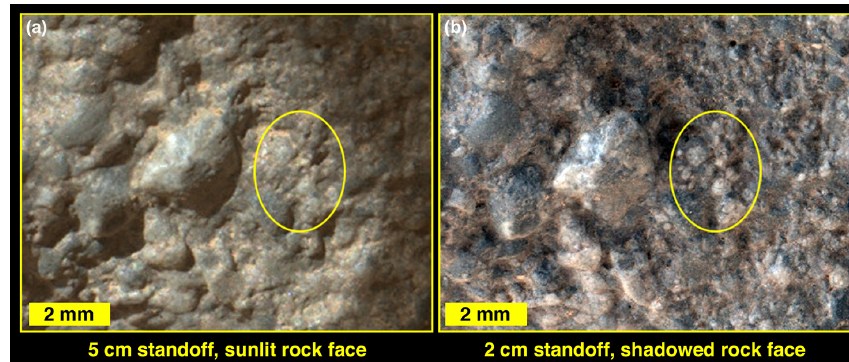
Figure 14. Information content in targets illuminated by the Sun and in full shadow can be complementary. This example is from the rock target Bardin Bluffs, imaged by MAHLI on sol 394 (14 September 2013). (a) Pebbly sandstone grains in sunlight, Sun from the upper left (shadowed by hardware at the right) in a portion of MAHLI focus merge product 0396MH0001700000104474R00. (b) Same rock surface in full shadow (cast by rover hardware) in MAHLI focus merge product 0396MH0001700000104470R00; this image has been contrast and color enhanced. Although the intrinsic spatial resolution of the two images differ, because they were acquired from different working distances, it is the difference in illumination conditions that provides complementary information about the rock. In full sunlight, the smoothness of the largest clast (just left of the yellow ellipse) results in specular reflections and grain boundaries that are difficult to identify on flatter regions of the rock. The sunlit face is ideal for discriminating grain shape and rock surface morphology. Considerably more color information is available in the shadowed image than the sunlit image. Individual white grains can be distinguished in the shadowed image (e.g., yellow ellipse), but not in the sunlit